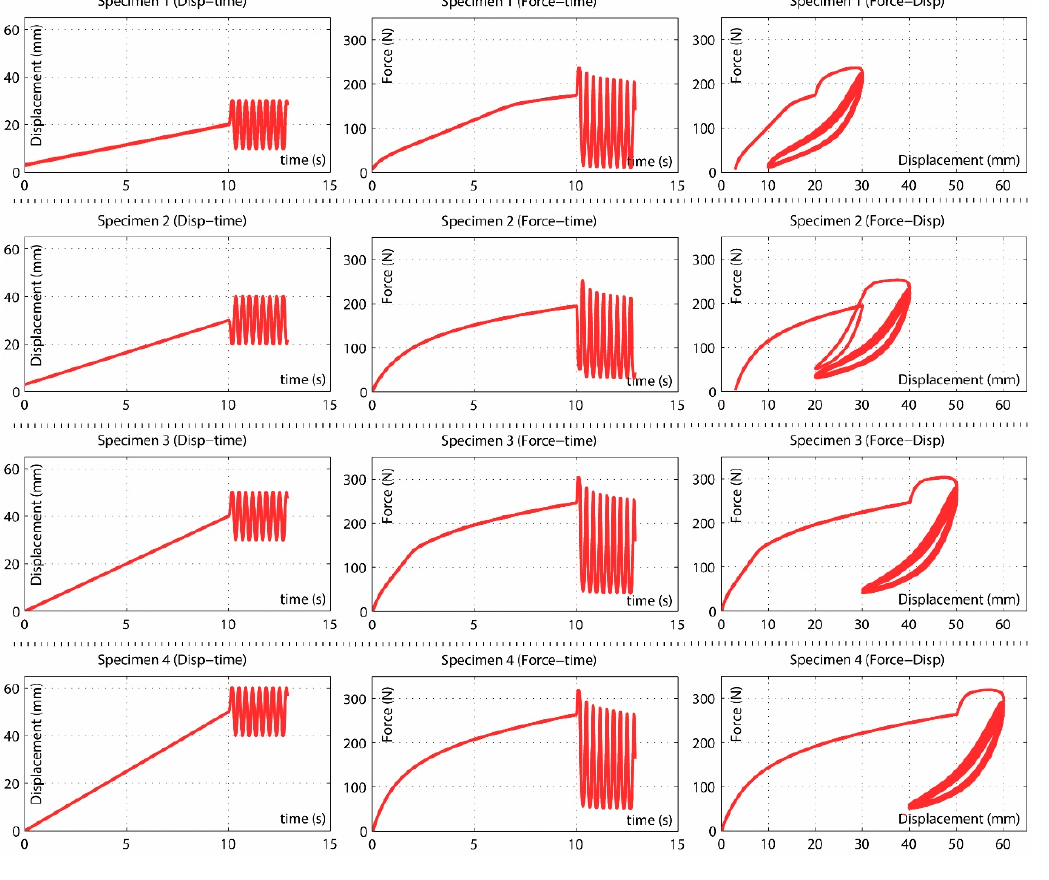
Figure 4. Force-displacement curves observed in the experiments.